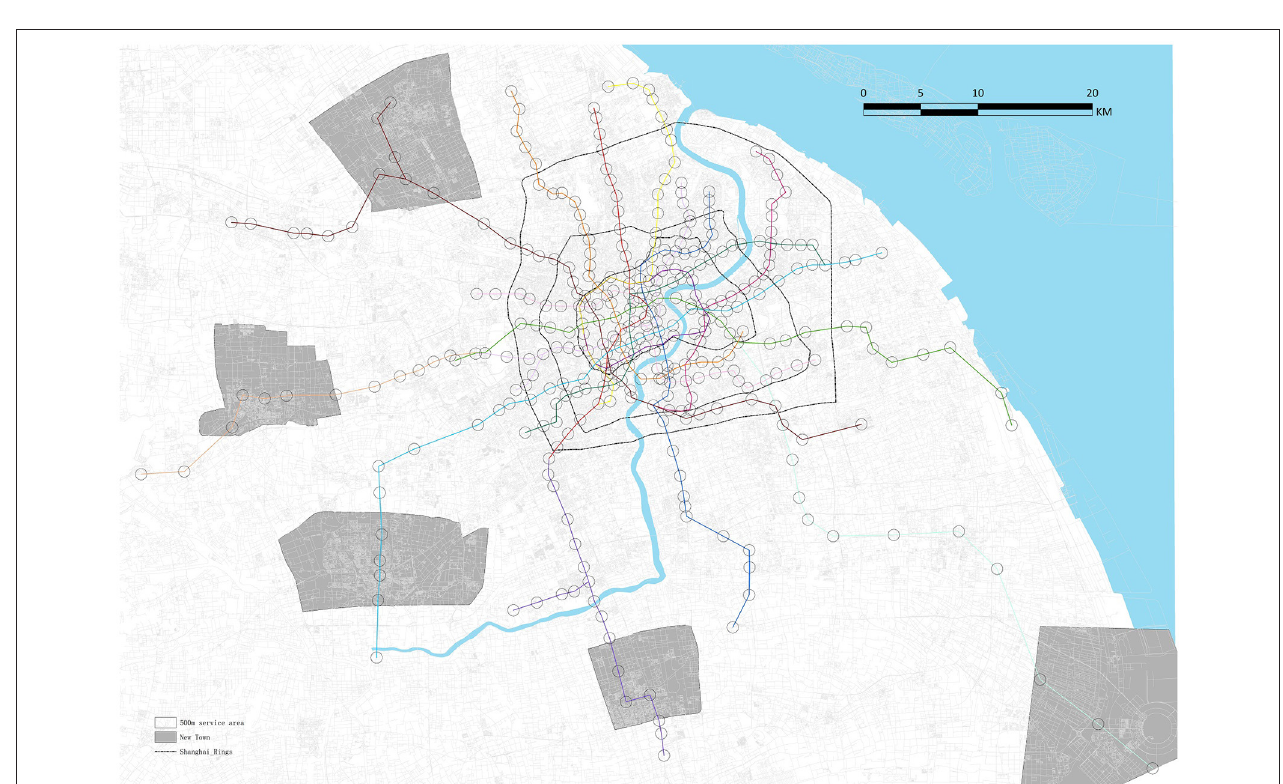
FIGURE 2 | The study area and 500m metro service